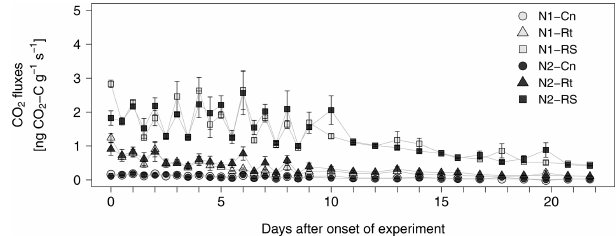
Figure 2. CO 2 fluxes from soils with two N levels (N1, N2) after in- corporation of maize root litter (Rt), maize root + shoot litter (RS), and control (Cn) without litter. Error bars show the standard error of mean values ( n = 4). When not visible, error bars are smaller than the symbols.